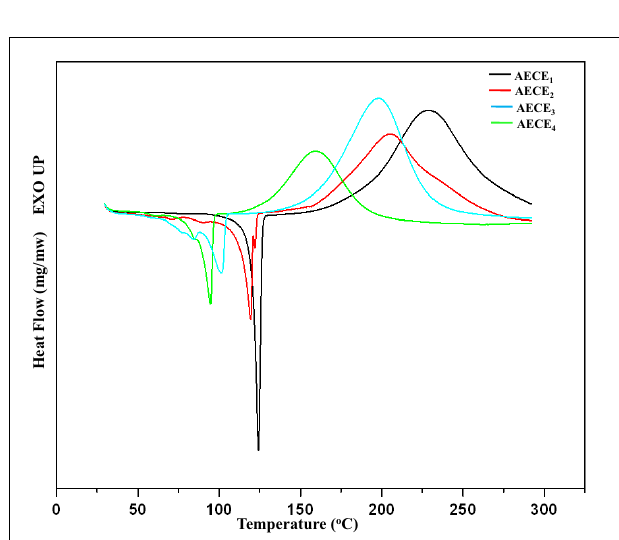
Figure 3 | FT-IR spectra of POSS-AECE nanocomposites.